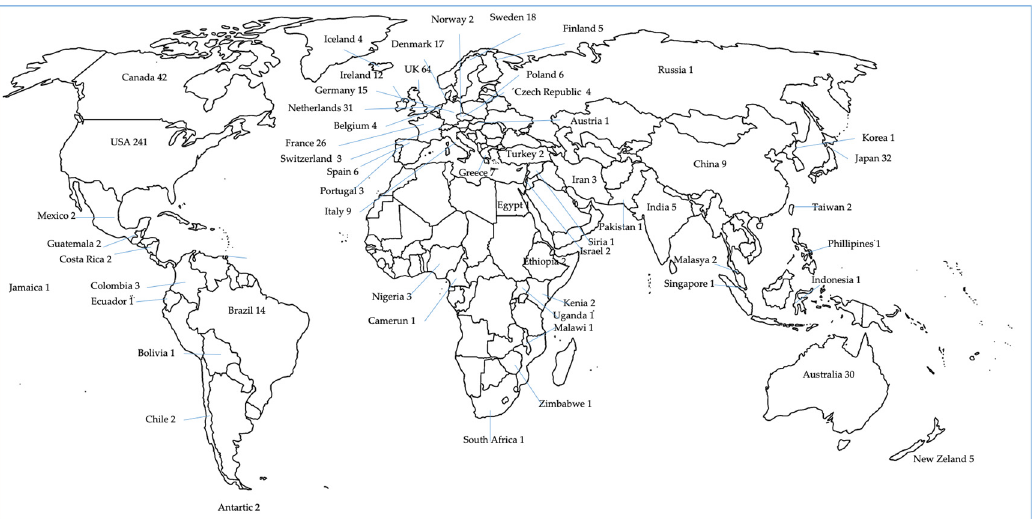
Figure 2. Country origin of the reviewed articles and number.